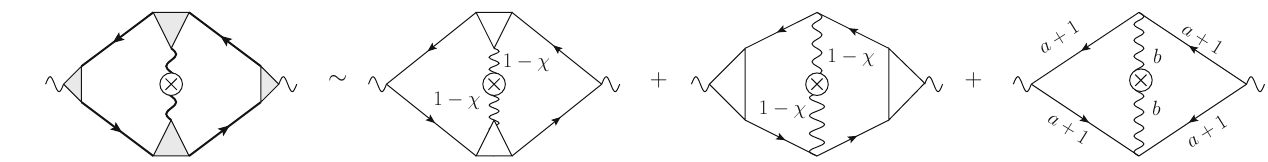
Fig. 9 An example of the calculation of the dressed diagram